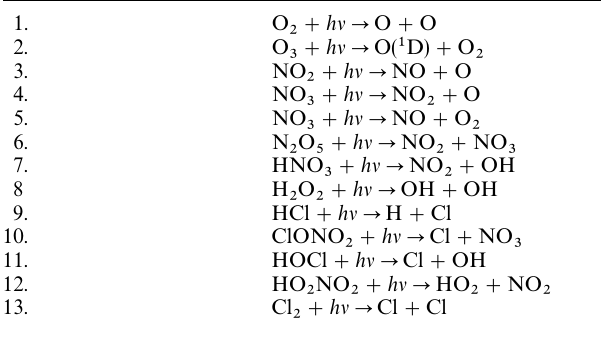
Table 2. List of gas phase photochemical reactions included in model